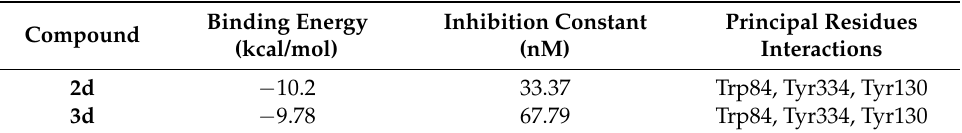
Table 3. Docking scores for compounds 2d and 3d